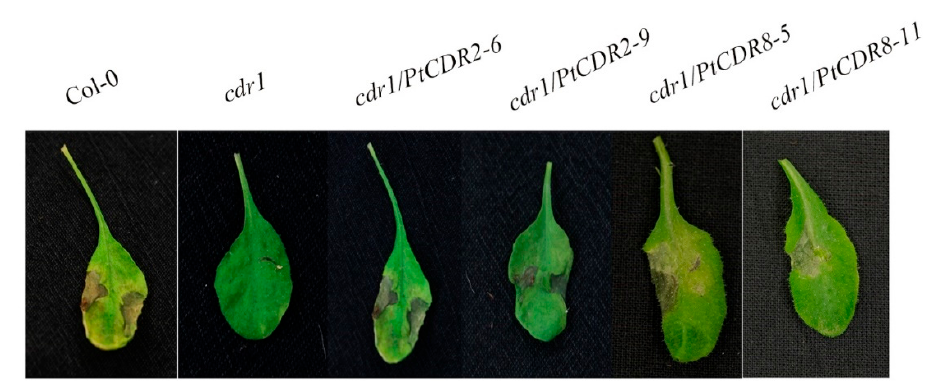
Figure 2. PtCDR2 and PtCDR8 restored hypersensitive response. Wild ‐ type Arabidopsis Col ‐ 0 , cdr1 mutant , PtCDR2 transgenic cdr1 line 6/line 9, and PtCDR8 transgenic cdr1 line 5/line 11 were infiltrated with Pseudomonas syringae pv. tomato strain DC3000 ( Pst DC3000) expressing avrRpt2 . Cell death or hypersensitive response (HR) was not observed in the infiltrated area of leaves of the cdr1 mutant; wild-type Arabidopsis , PtCDR2 transgenic cdr1 lines, and PtCDR8 transgenic cdr1 lines all showed cell death or HR in the infiltrated leaf area.